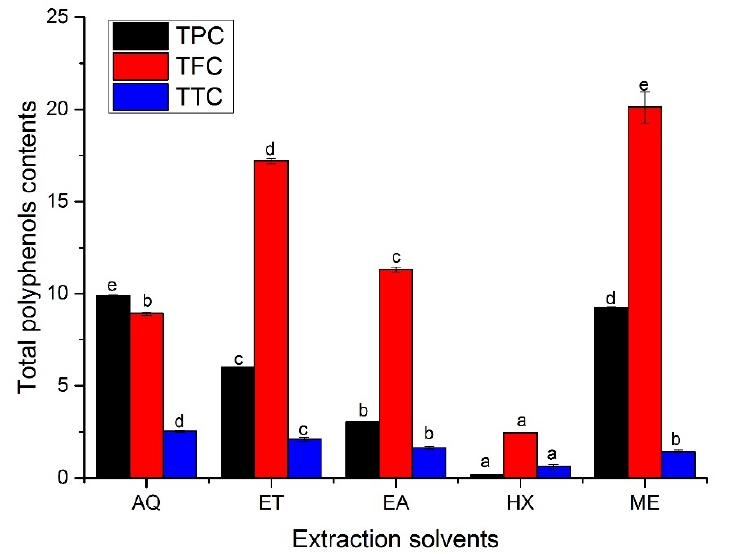
Figure 1. Total phenols, flavonoids, and tannin contents in the A. hendersonii leaf extracts obtained using various solvents. TPC: total phenol content (mg GAE/g DW); TFC: total flavonoid content (mg QE/g DW); TTC: total tannin content (mg CE/g DW); GAE: gallic acid equivalents; QE: quercetin equivalents; CE: Catechin equivalents. AQ: Water; ET: Ethanol; EA: Ethylacetate, HX: n-Hexane;